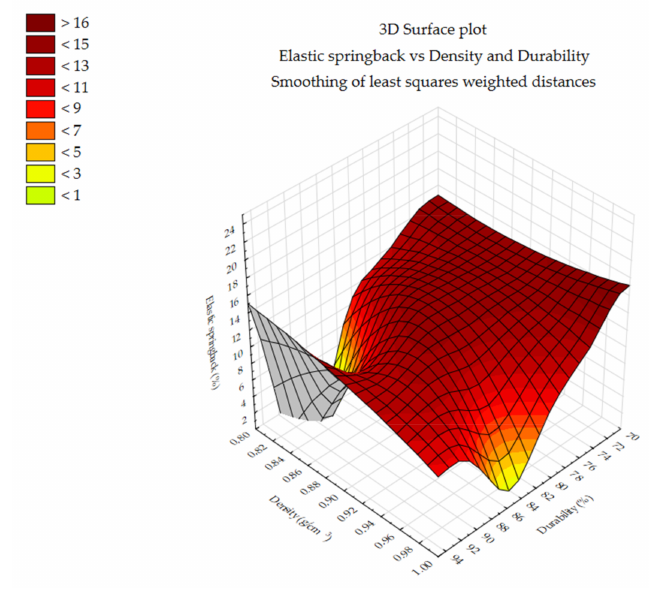
Figure 10. Elastic springback vs. density and durability—sida. In the case of sida, the correlation of elastic springback with density was at r = 0.7677, which is lower than the other